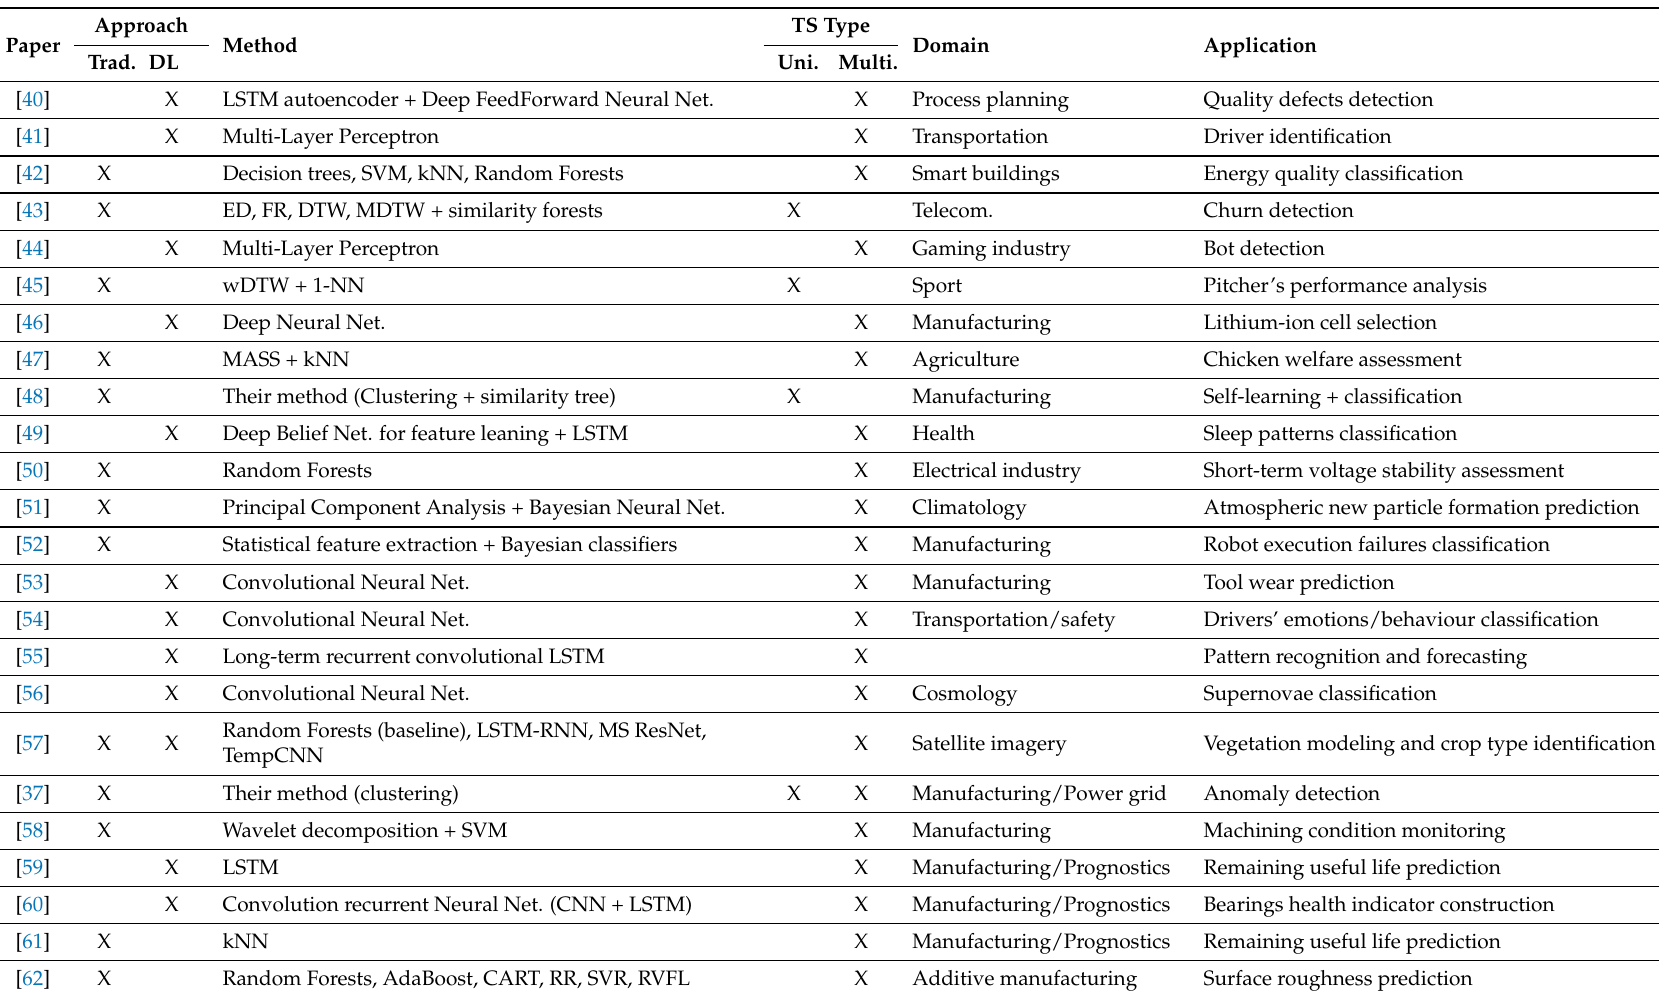
Table 1. Implementation of time series classification (TSC) on industrial